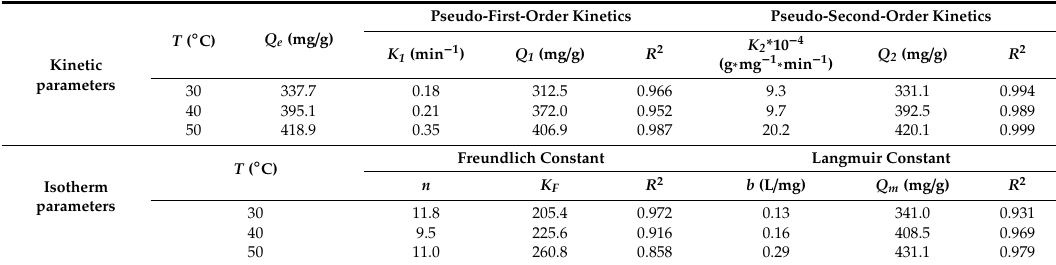
Figure 5. ( a ) Adsorption kinetics of MB on S3 (MB: 400 mg / L, 120 mL; adsorbent dose: 0.1 g; pH: 8) and the non-linear fitting curves using pseudo-first-order and pseudo-second-order models. ( b ) Adsorption isotherms of MB on S3 (adsorbent dose: 1 mg / mL, 10 mL; pH: 8; contact time 120 min) and the non-linear fitting curves using Freundlich and Langmuir models. Table 2. Kinetic and isotherm parameters for adsorption of methylene blue on 80% ethanol insoluble subdivision